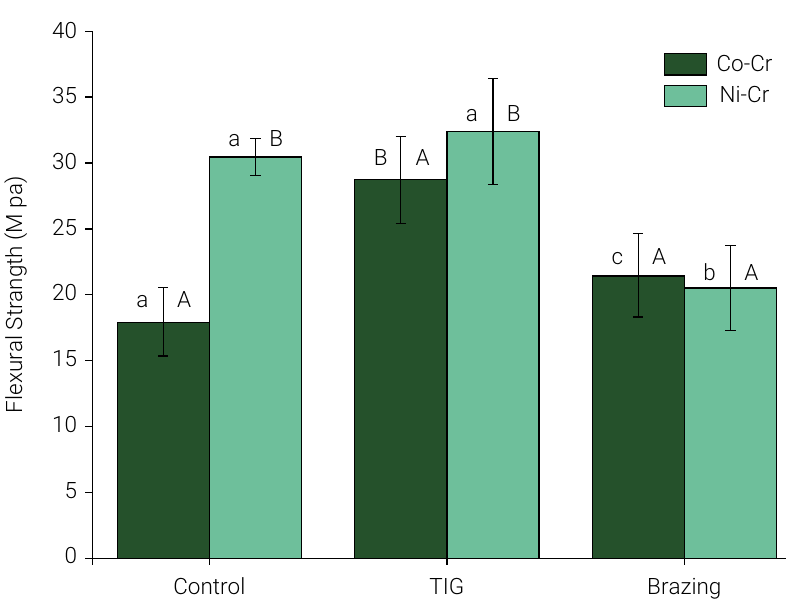
Figure 3. Mean flexural strengths (MPa) in the control, TIG, and brazing groups based on the different welding